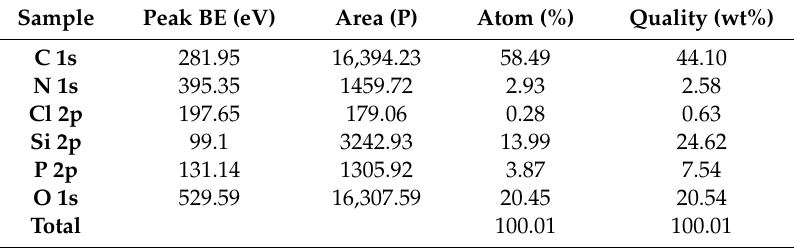
Table 1. Elemental data of HSPCTP.